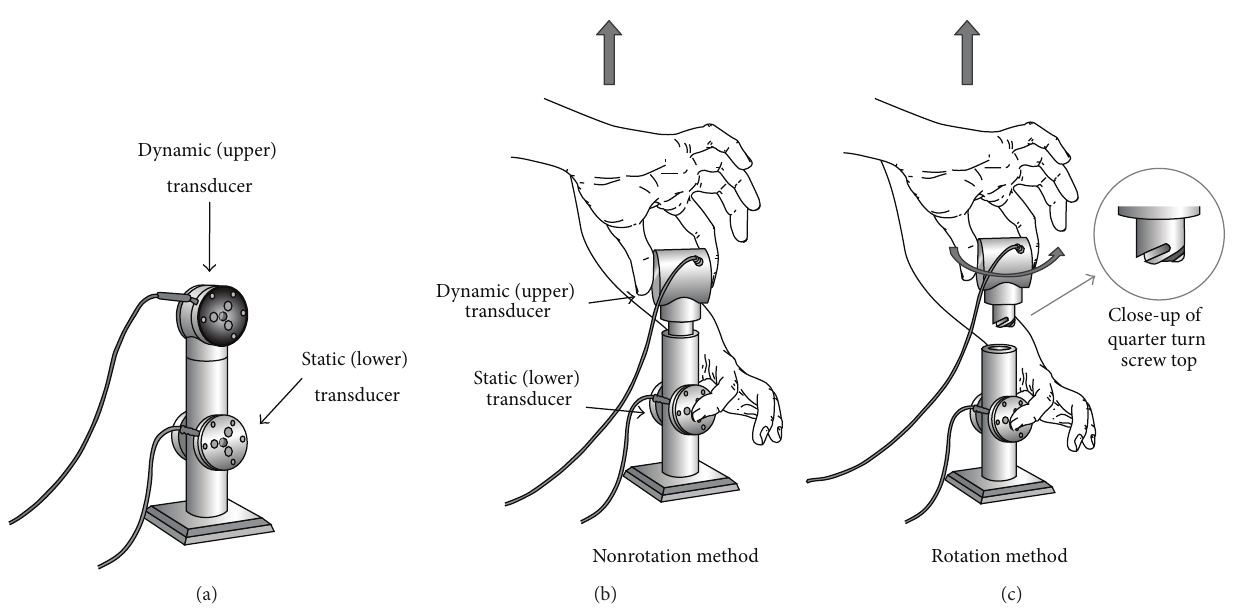
Figure 1: Schematics of the bimanual tasks examined in this study. (a) The device with sensors embedded in aluminum housings. (b) An example of the task performed with the nonrotation method; static and dynamic transducers are indicated. (c) An example of the task performed with the rotation method. A quarter turn rotation in the counter-clockwise direction was required when performing tasks with the rotation method, as shown in the magnified view of the